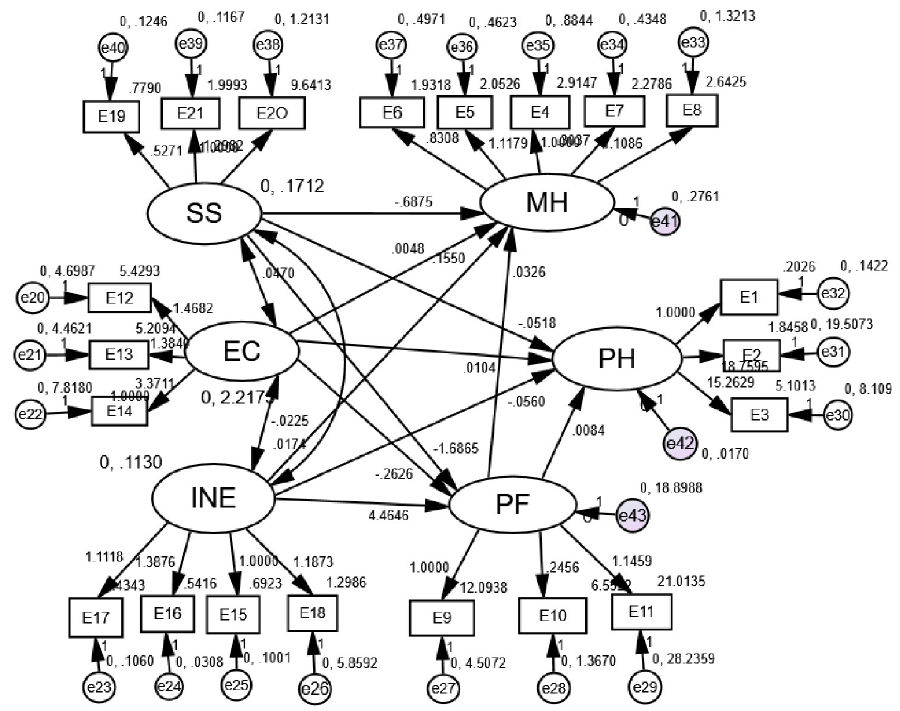
Fig 1. Structural equation model of the effect of intergenerational support on the health of the elderly in rural areas and its mechanism.